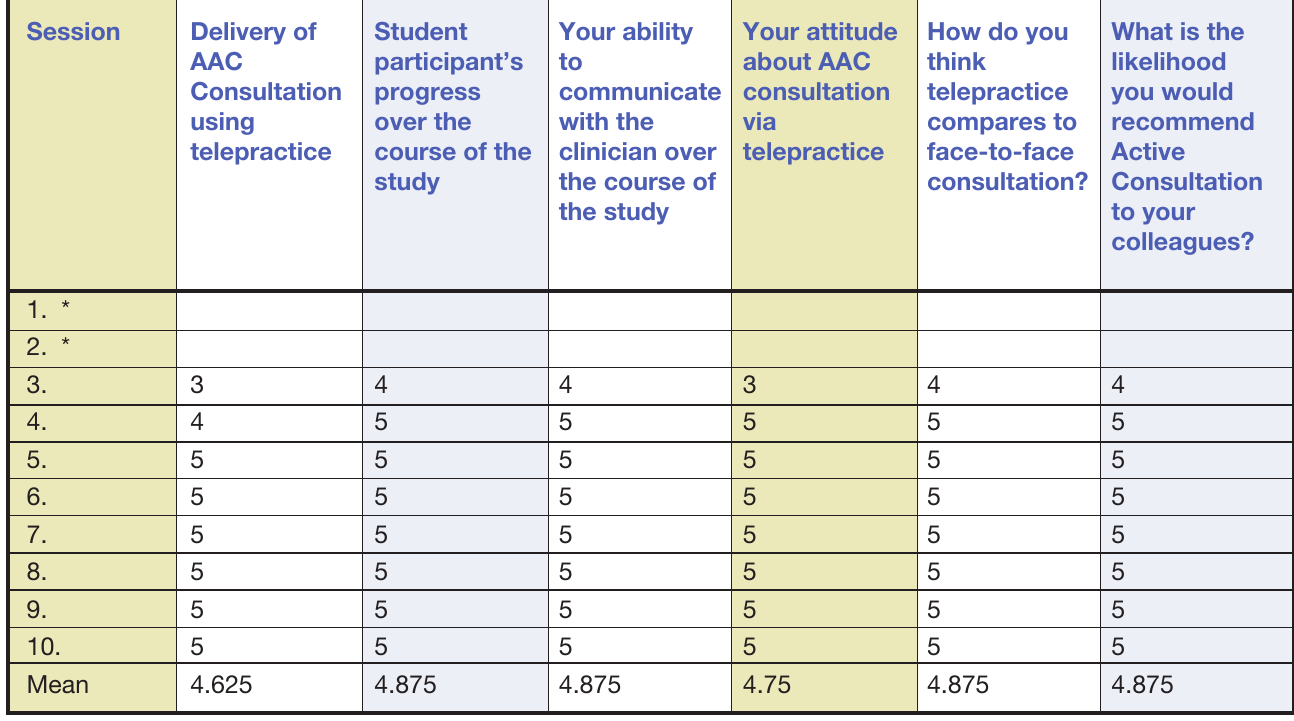
Data is derived from satisfaction surveys that used a 5-point Likert scale with 1 = Not Very Good, 2 = Below Average, 3 = Average, 4 = Above Average, and 5 = Very Good. Averages were calculated for each question over the course of the Active Consultation